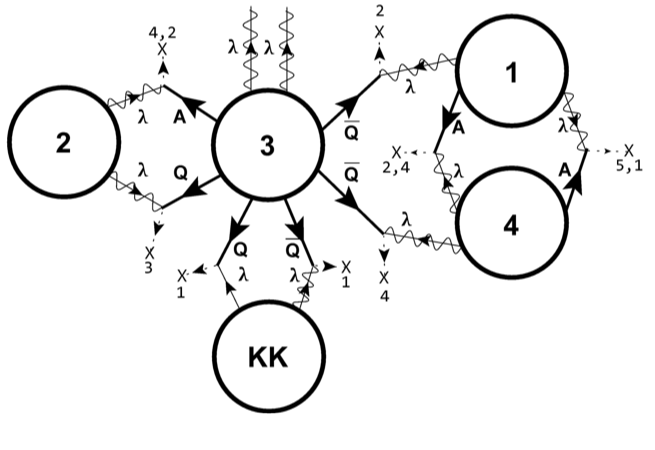
Figure 7: A sketch of the instanton for F =